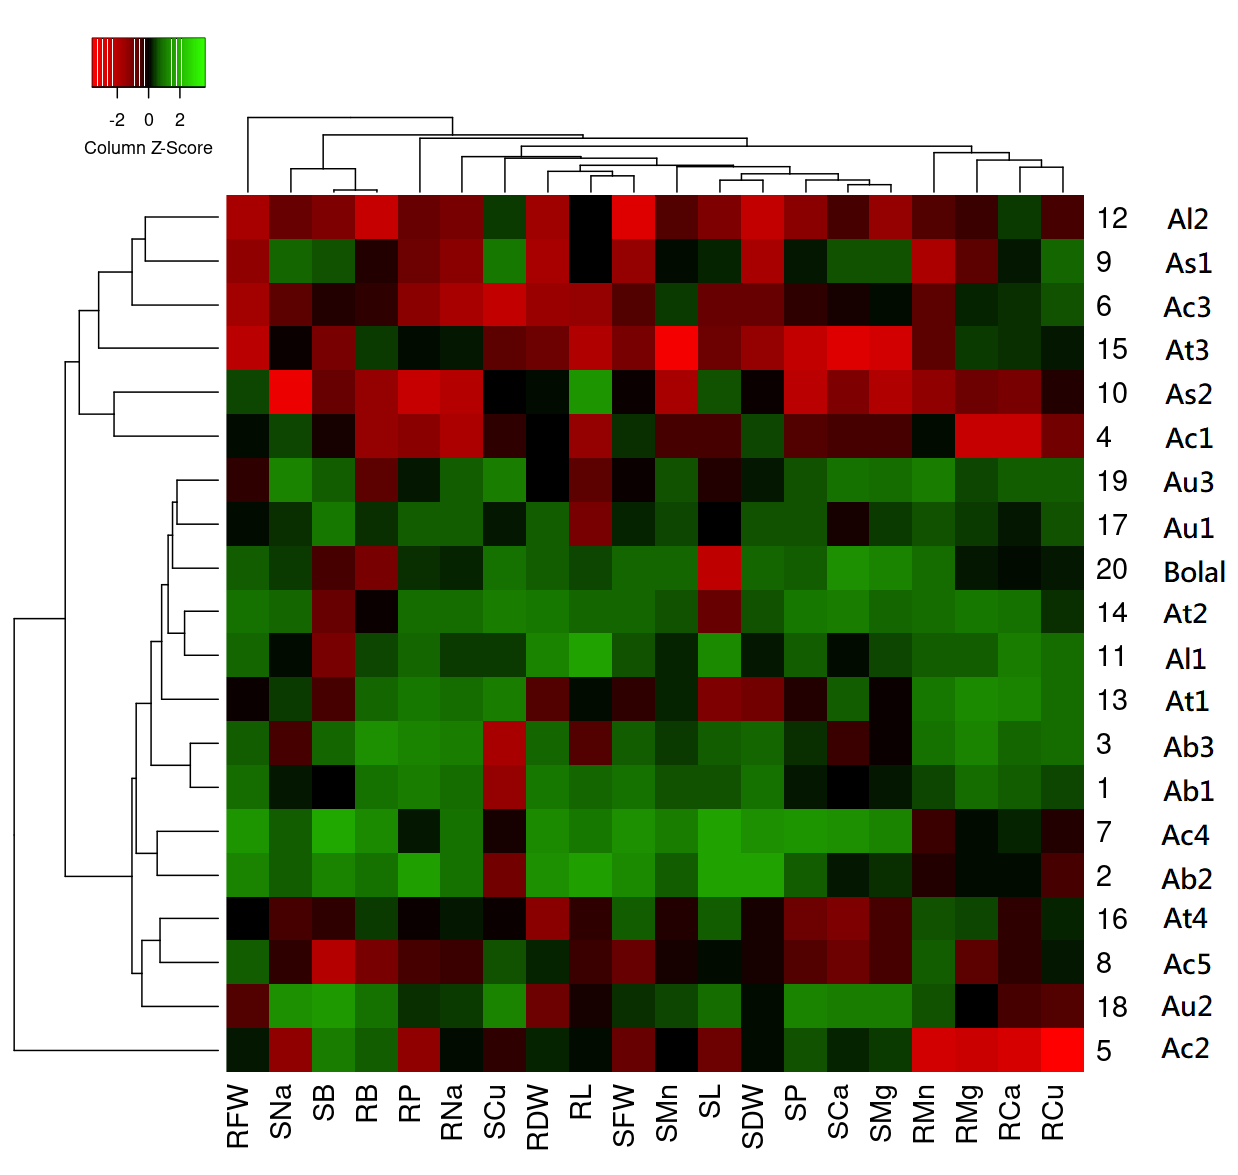
Figure 1. Heat map showing the genetic variation of 19 Aegilops genotypes together with the check genotype, Bolal 2973, based on the nutrient uptake and the previously studied growth parameters under high B (10 mM) treatment. The color indicates the Z score for each accession: dark green shows the increment in the percentage of the nutrient uptake values of the genotypes in highly toxic B in comparison to control, whereas red shows the decrement in the percentage of the nutrient uptake of the genotypes in B toxicity in comparison to control. The accessions were grouped into two different clusters (C1–C2) with C1 divided into two subclusters, C1A and C1B, according to their reaction to highly toxic B in terms of several previously studied traits in Khan et al. (2021) including RL (root length), SL (shoot length), RFW (root fresh weight), SFW (shoot fresh weight), RDW (root dry weight), SDW (shoot dry weight), and the nutrient uptake estimated in this study including RCa (root calcium), SCa (shoot calcium), RP (root phosphorus), SP (shoot phosphorus), RNa (root sodium), SNa (shoot sodium), RMg (root magnesium), SMg (shoot magnesium), RMn (root manganese), SMn (shoot manganese), RCu (root copper), SCu (shoot copper), RB (root boron), and SB (shoot boron) uptake.